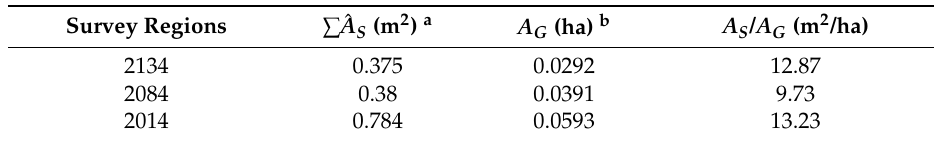
Table 3. A S /A G calculations based on the field survey within the three survey regions in site 2 of the ASWP site.